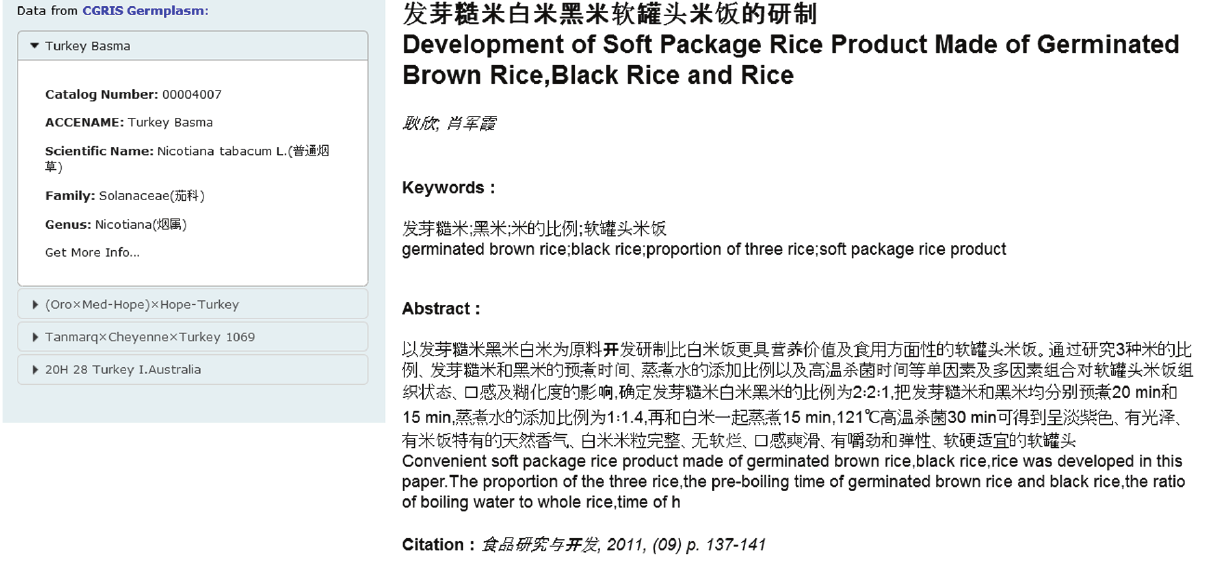
Figure 3. The CGRIS widget showing a record integrated from the Chinese Agricultural Scitech Documents Database. This allows users to tell the data source of the main bibliographic data of the AGRIS article.